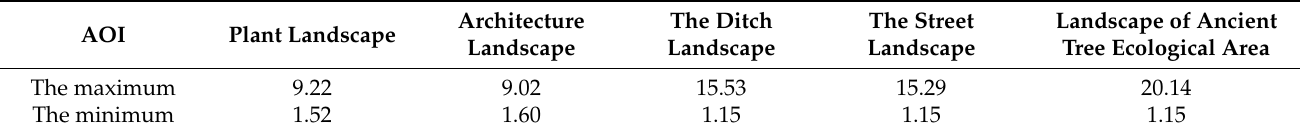
Table 2. Statistics of maximum and minimum value of AOI.